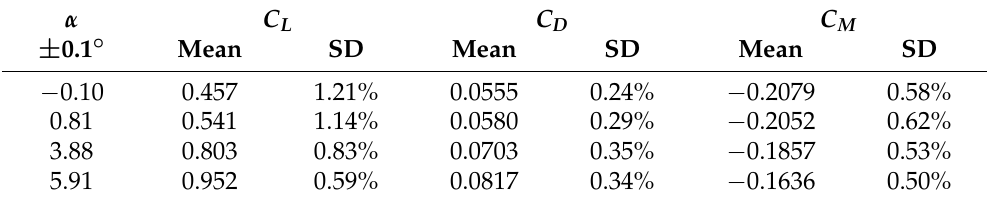
Table 3. Uncertainty in measurements of lift, drag, and pitching moment coefficients. WB configura- tion. Test conditions: V = 35m/s, Re = 315,000 at β = 0°.